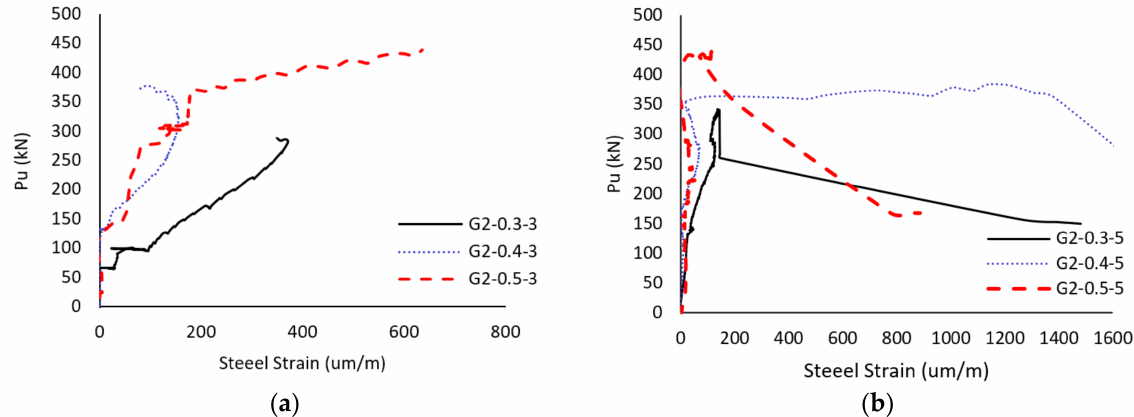
Figure 7. Relation between ultimate load and strains in the flange longitudinal steel for different flange thicknesses at flange width ratios of 3 and 5. ( a ) Specimens with ρ b = 3; ( b ) specimens with ρ b =